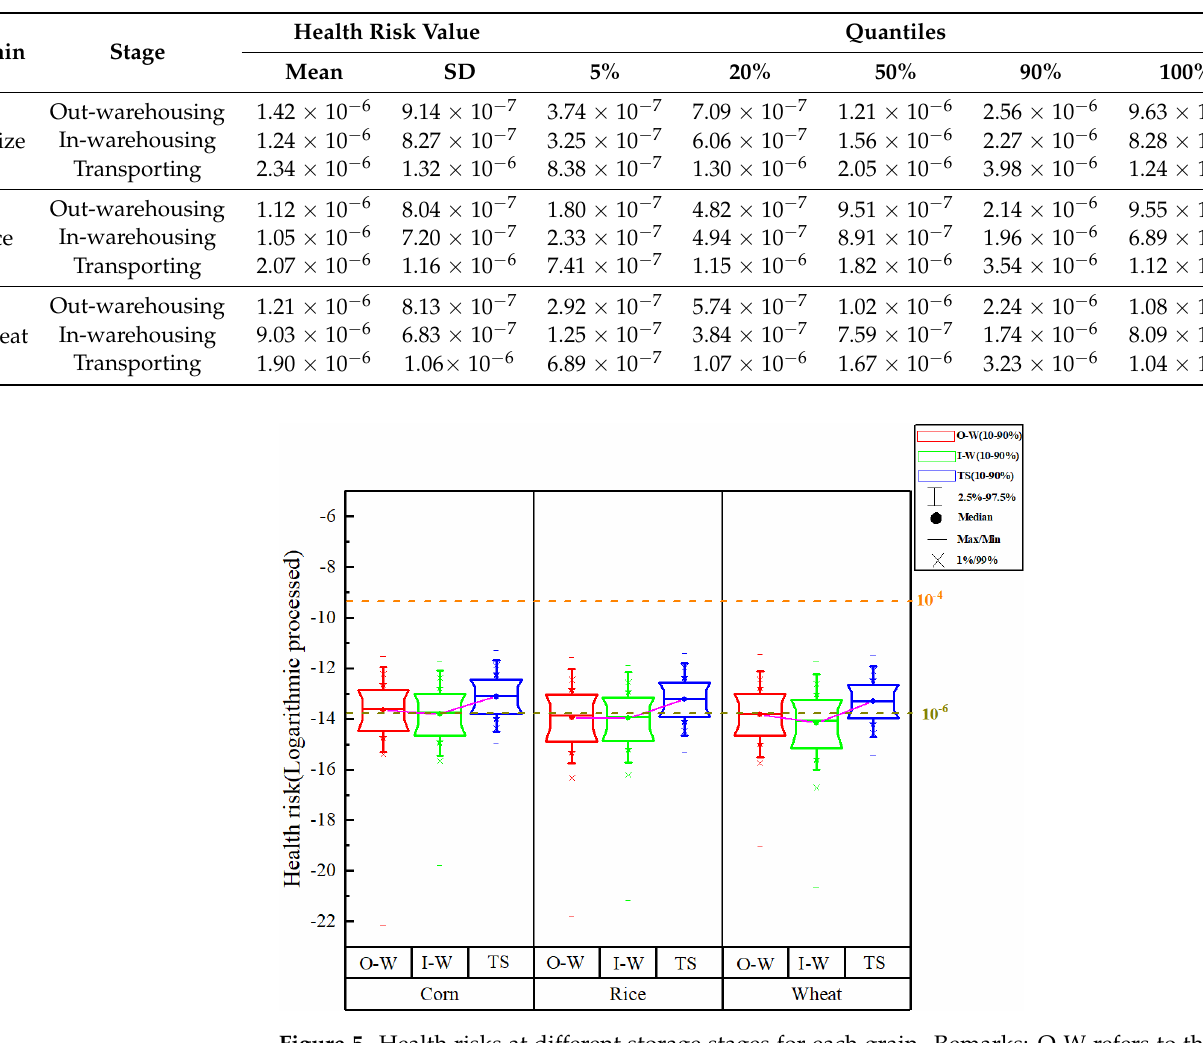
Figure 5. Health risks at different storage stages for each grain. Remarks: O-W refers to the out- warehousing stage; I-W refers to the in-warehousing stage; and TS refers to the transporting stage. followed a lognormal distribution. The out-warehousing stage was 1.42 × 10 − 6 ± 9.14 × 10 − 7 , the in-warehousing stage was 1.24 × 10 − 6 ± 8.27 × 10 − 7 , and the transporting stage was 2.34 × 10 − 6 ± 1.32 × 10 − 6 . Themaximumvalueswere9.63 × 10 − 6 , 8.28 × 10 − 6 , and 1.25 × 10 −